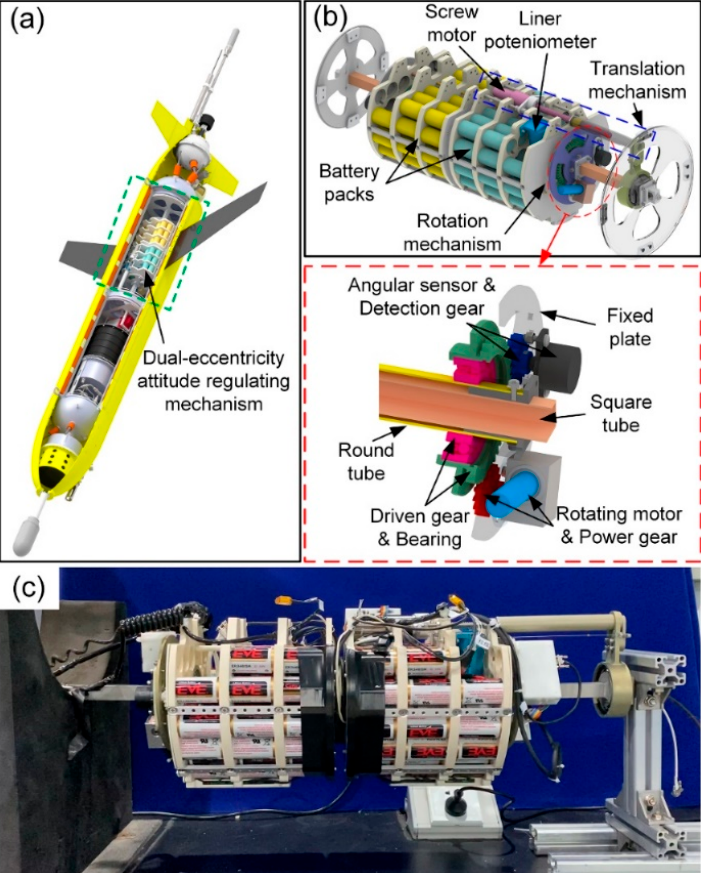
Figure 1. The dual-eccentric attitude regulating mechanism: ( a ) Installation position on Petrel-X PLUS ; ( b ) 3D model; ( c ) DARM in testing.